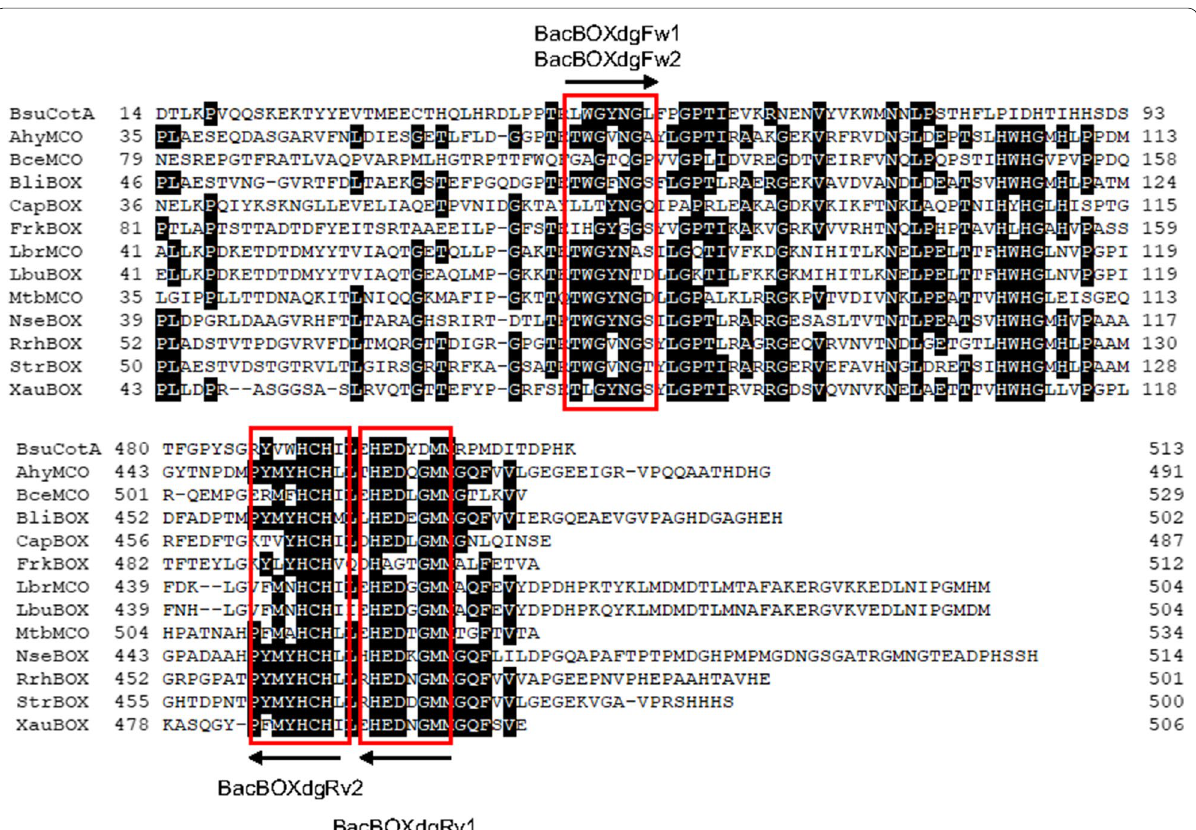
Fig. 1 Alignment analysis of several MCOs to design the primers for isolating target genes from metagenomes. Amino acid sequences were aligned using ClustalW and conserved amino acids were denoted by white letters on black boxes. The conserved amino acid sequences surrounded by a red square were used for design of each primer. B. subtilis (BsuCosA; GenBank accession No.: CAB12449.1), Actinoalloteichus hymeniacidonis (AhyMCO; AOS64008), Burkholderia cepacia (BceMCO; AFQ47357), Brevibacterium linens (BliBOX; KHS53242), Cyanobacterium aponinum